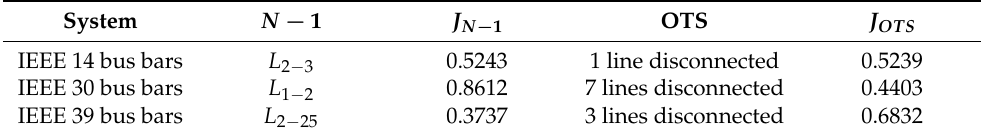
Table 5. Test systems to maximize